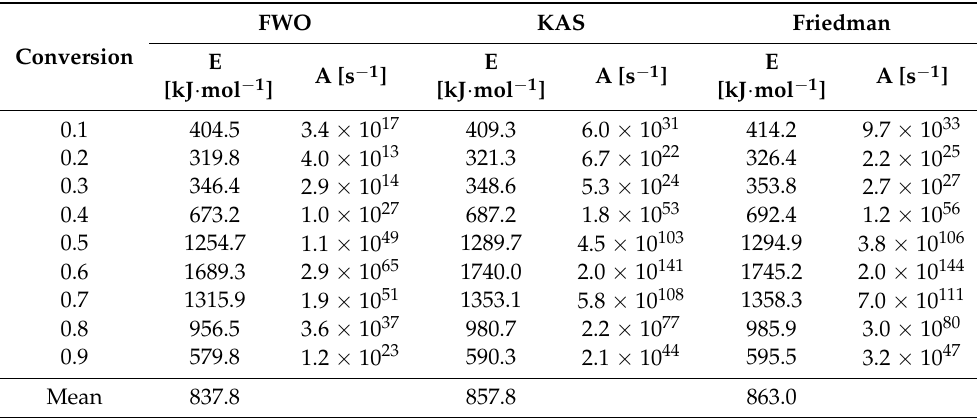
Table 9. Kinetic parameters of TTDA at heating rates less than 20 min − 1 .